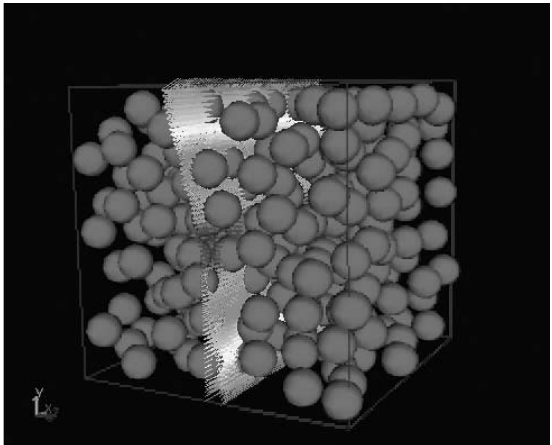
Fig. 2 Flow of a suspension under shear; arrows indicate the velocity field on a plane normal to the